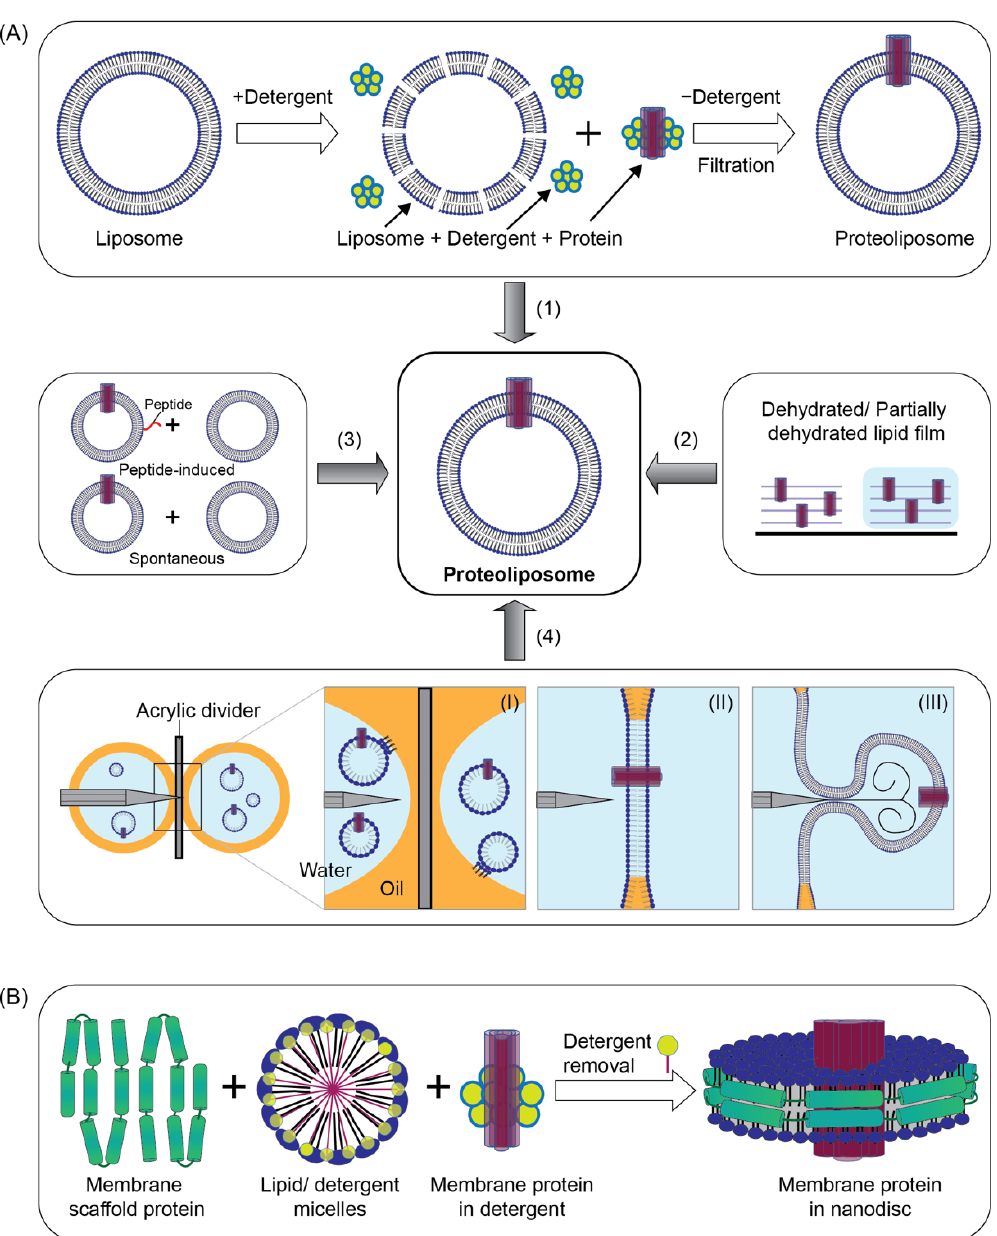
Figure 3. Schematic showing methods for reconstitution of membrane protein into model lipid bilayers. ( A ) Selected methods for proteoliposome preparation: (1) Direct reconstitution method: Preformed liposome and detergent solubilized proteins are mixed. Detergent facilitates the insertion of proteins in the lipid bilayers by a modest destabilization of the lipid